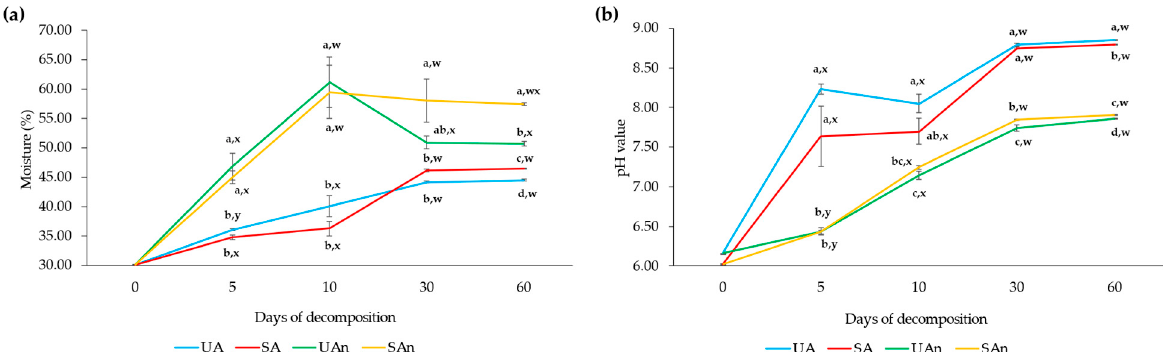
Figure 2. Changes in the ( a ) moisture content (%) and ( b ) pH during decomposition of poultry carcasses. UA, SA, UAn, and SAn represent unsterilized soil–aerobic condition, sterilized soil–aerobic condition, unsterilized soil–anaerobic condition, and sterilized soil–anaerobic condition, respectively. The 0, 5, 10, 30, and 60 represent the sampling period. Different letters in the figure (a–d) indicate the significant differences ( p < 0.05) between burial set-ups at each sampling day, while (w–z) indicate the significant differences ( p < 0.05) between the sampling periods of each burial set-up.